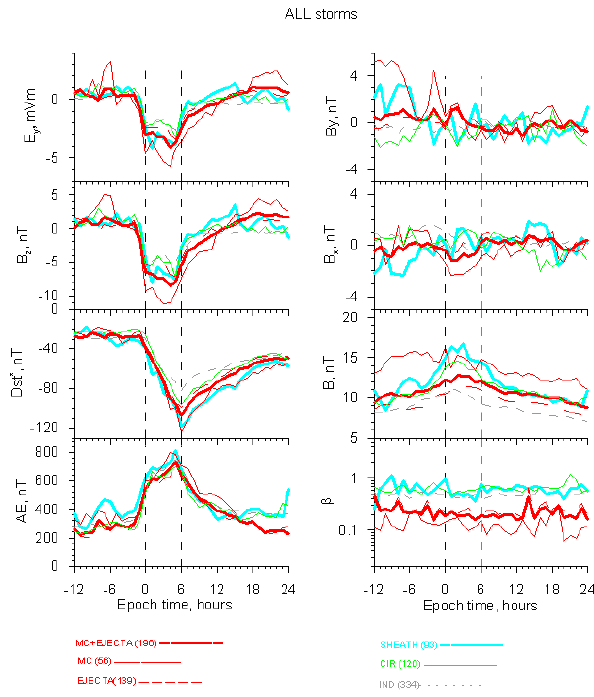
Fig. 2. The same as in Fig. 1 for parameters: (left column) E y Fig. 2. The same as in Fig.1 for parameters: (Left column) Ey - – electric field, B z – GSM southward components of IMF, Dst ∗ electric field, Bz - GSM southward components of IMF, Dst ∗ - dynamic pressure-corrected Dst index (Burton et al., 1975), AE in- – dynamic pressure-corrected Dst index (Burton et al., 1975), AE dex, (Right) By,Bx,B - GSM components and magnitude of IMF, index, (right) B y ,B x ,B – GSM components and magnitude of IMF, β - ratio of thermal to magnetic pressure. β – ratio of thermal to magnetic pressure. Fig. 2. The same as in Fig.1 for parameters: (Left column) Ey - electric field, Bz - GSM southward components of IMF, Dst ∗ - dynamic pressure-corrected Dst index (Burton et al., 1975), AE in- dex, (Right) By,Bx,B - GSM components and magnitude of IMF, AE index, (right) B y ,B x ,B – GSM components and magni- β - ratio of thermal to magnetic pressure. tude of IMF, β – ratio of proton thermal to magnetic